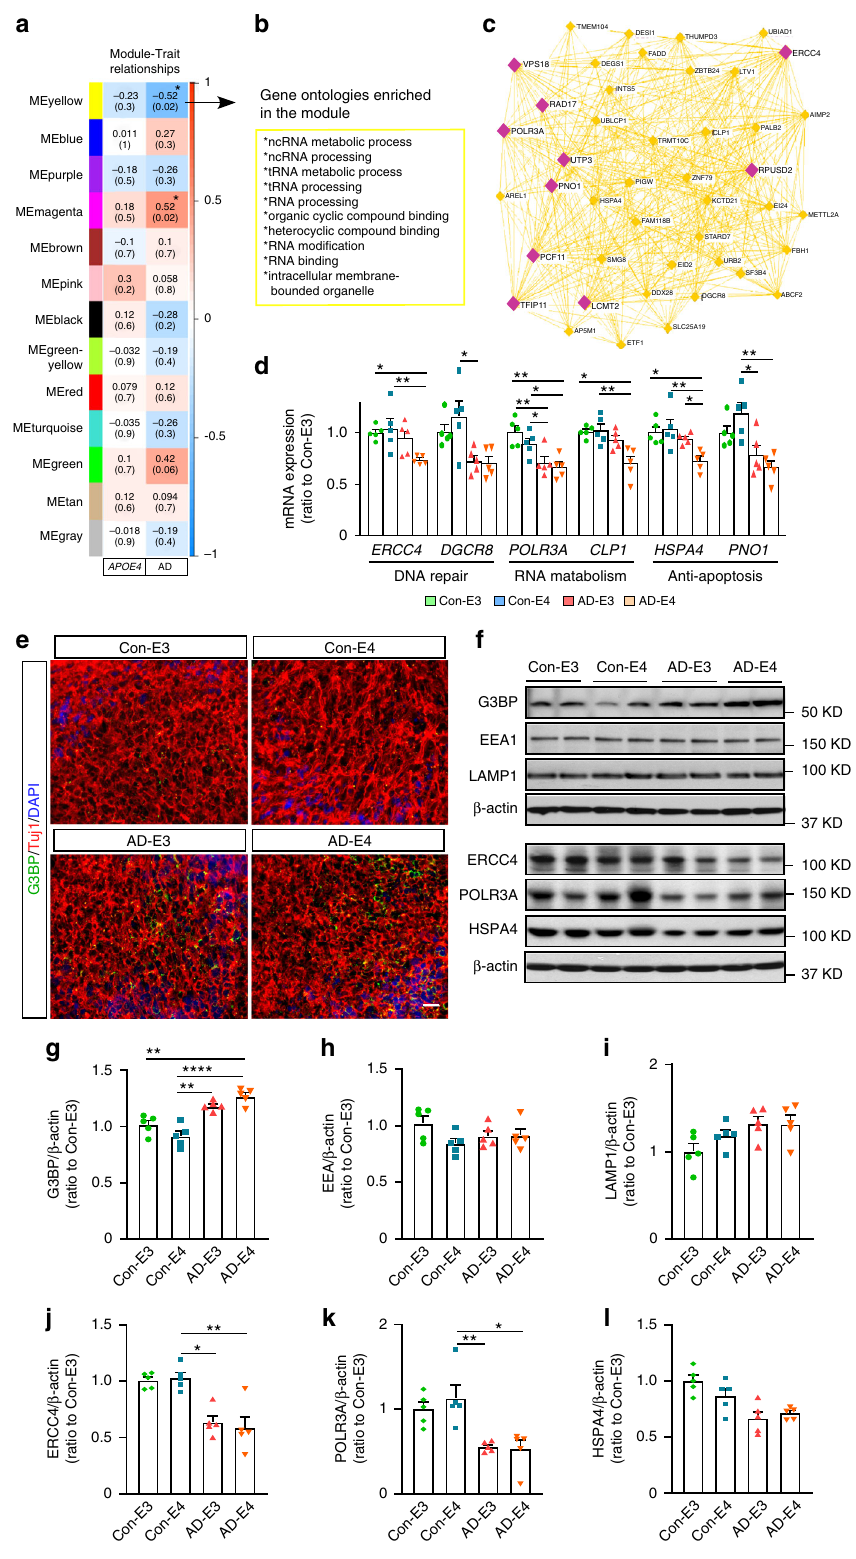
AD organoids (Fig. 6e). We further quanti fi ed G3BP, endosome marker protein early endosome antigen 1 (EEA1), and lysosome marker protein lysosomal-associated membrane protein 1 (LAMP1) by western blotting, and found the interactive effect between APOE4 and AD status;